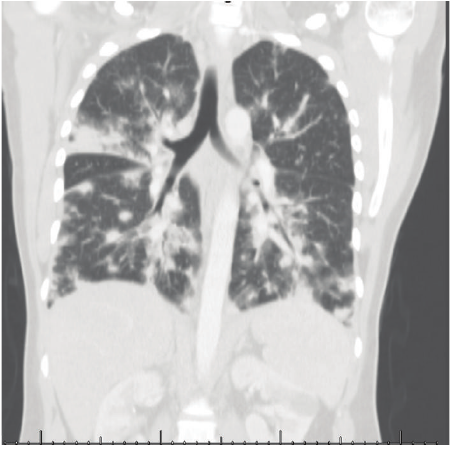
Figure 2: Initial chest CT scan at the ICU, revealing bilateral patchy infiltrates suggestive of lung KS or alveolar hemorrhage.